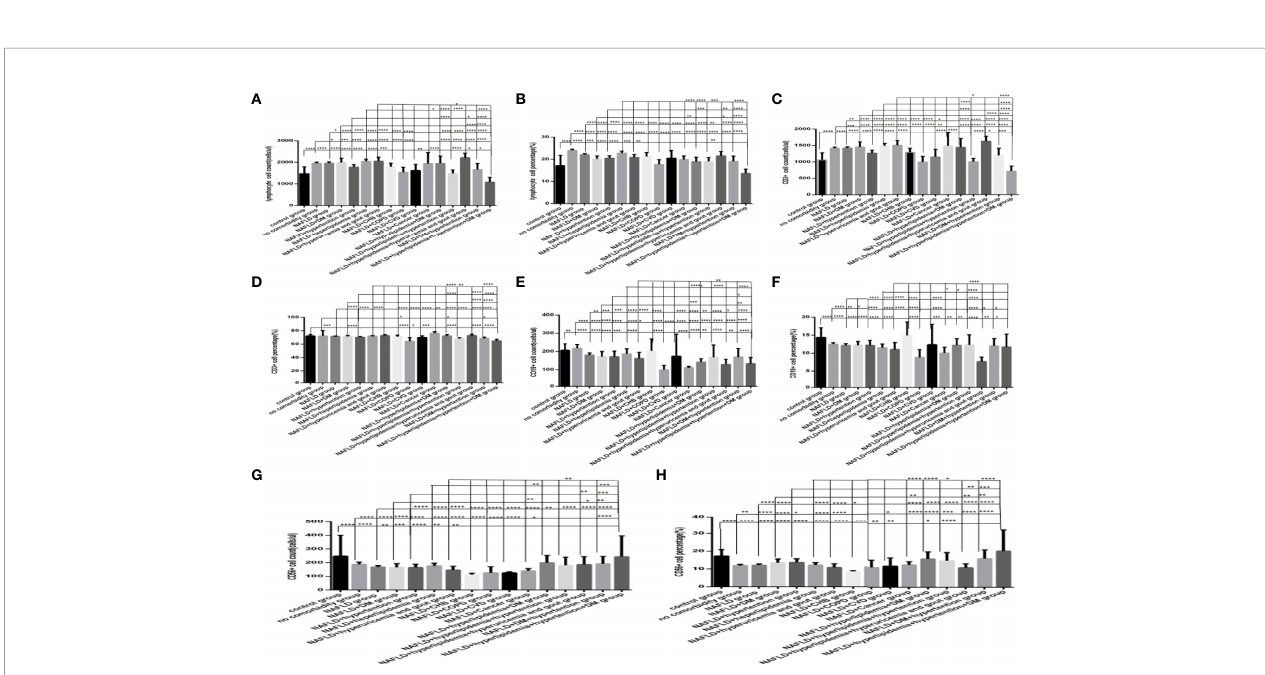
FIGURE 10 | Comparison of lymphocyte, T, B and NK cell subset counts and percentages among the control group, the no comorbidity group, with NAFLD group and with each combination of NAFLD and other comorbidities group ( n =773; control, no comorbidity, NAFLD, and each combination of NAFLD and other comorbidities group, n =55, 253, 304, 39, 50, 88, 26, 13, 6, 6, 6, 17, 19, 11, 14 and 5 cases, respectively). Abbreviations: CHB, chronic hepatitis B.CKD, chronic kidney disease. COPD, chronic obstructive pulmonary disease. COVID-19, coronavirus disease 2019.CVD, cardiovascular disease. NAFLD, nonalcoholic fatty liver disease. DM, diabetes mellitus. HT, Hypertention. HL, heperlipidemia. HU, hyperuricemia and gout. (A) lymphocyte count. (B) lymphocyte percentage. (C) CD3+ count. (D) CD3+ percentage. (E) CD19+ count. (F) CD19+ percentage. (G) CD56+ count. (H) CD56+ percentage. Unpaired one-way ANOVA was used for intergroup comparisons ( A, B, C, D, E, F, G, H , P all < 0.0001). Unpaired t -tests were used for comparisons with the control group, and with the no comorbidity group, with NAFLD group, with NAFLD plus DM group, with NAFLD plus hypertension group, with NAFLD plus hyperlipidemia group, with NAFLD plus hyperuricemia and gout group, * P < 0.05, ** P < 0.01, *** P < 0.001, **** P < 0.0001.